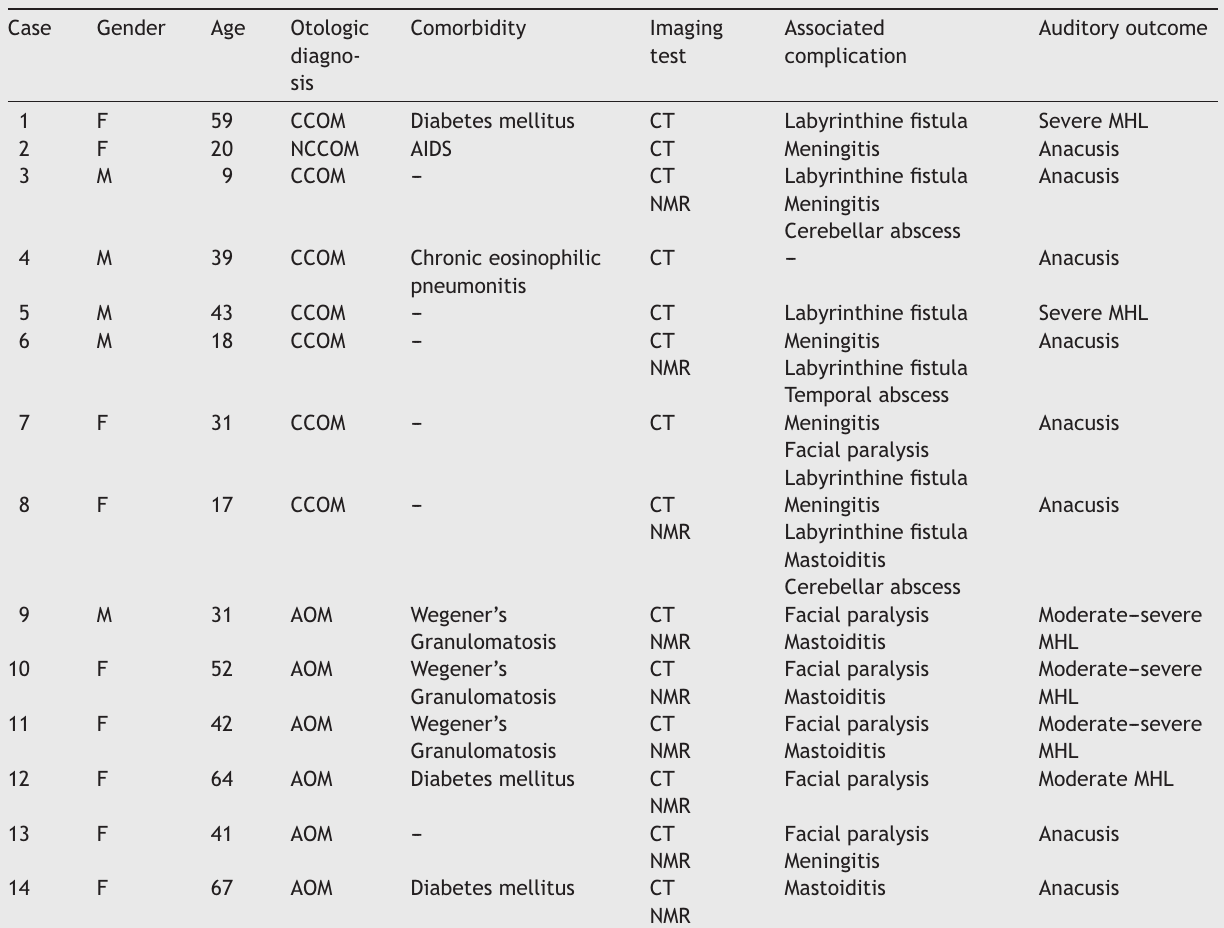
Description of cases.